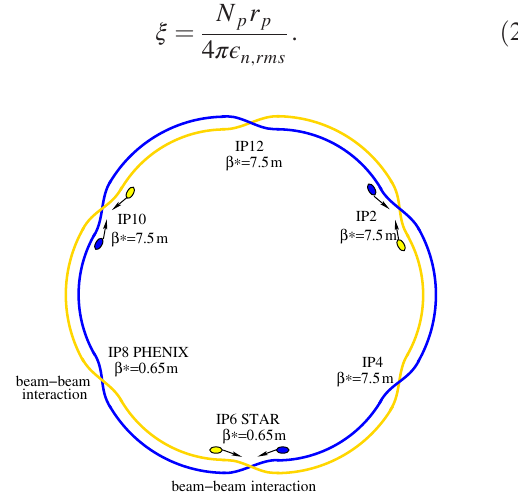
FIG. 1. Layout of RHIC. Particles circulate clockwise in the Blue ring and counterclockwise in the Yellow